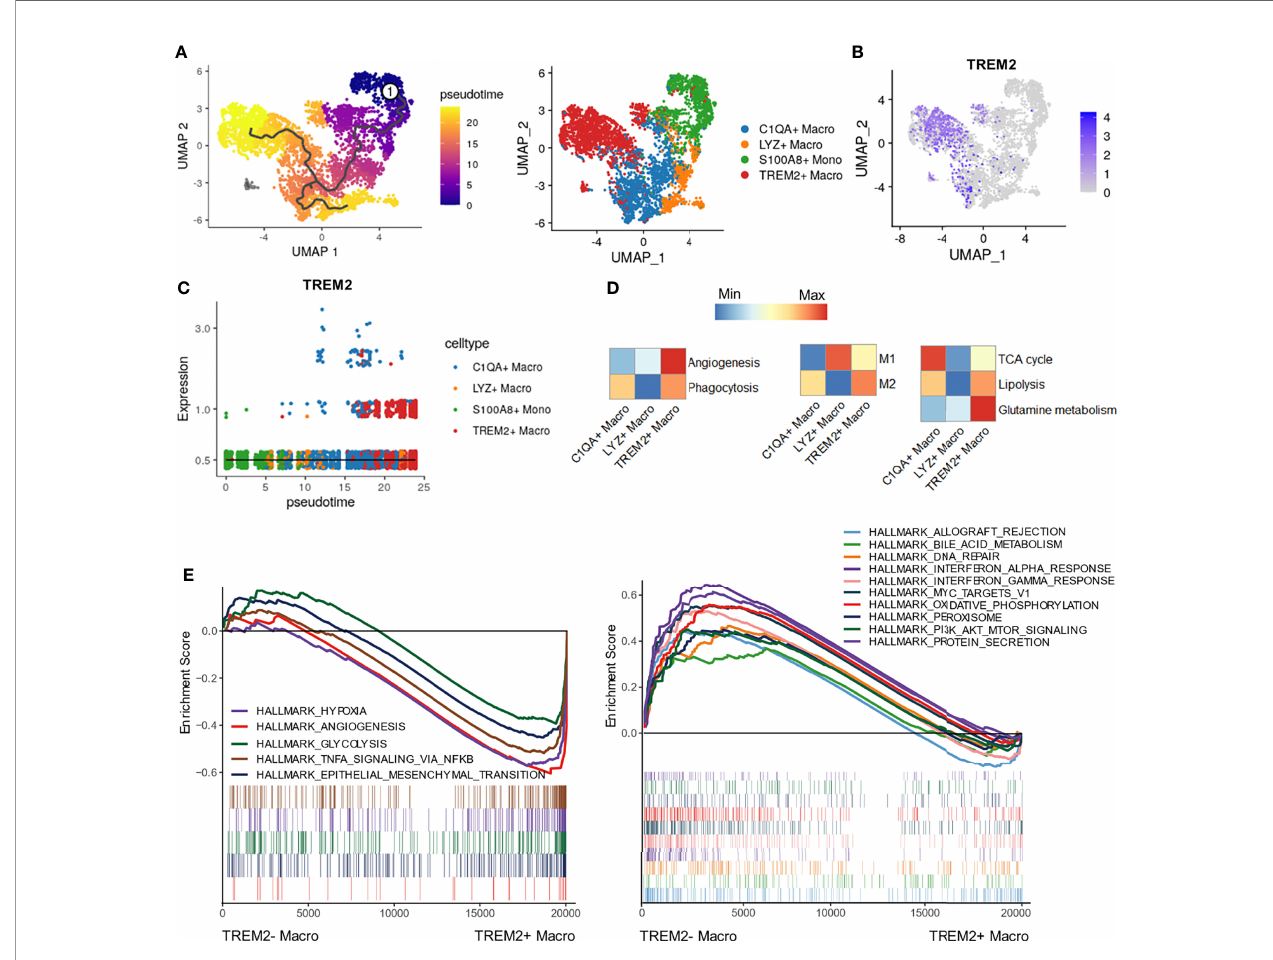
FIGURE 4 | Cellular trajectory and functional phenotypes of TREM2 + macrophages. (A) Pseudotime trajectory analysis of TREM2 + macrophages. (B) UMAP plot showing the expression of TREM2 in macrophage subpopulations and monocytes. (C) 2D pseudotime graph showing the dynamic change in TREM2 expression. Cell subtypes are labeled by colors. (D) Heatmaps showing different expression patterns of the indicated signature genes among macrophage subtypes calculated by GSVA. (E) Enrichment plots of signi fi cantly enriched hallmark gene sets in TREM2 + and TREM2 -